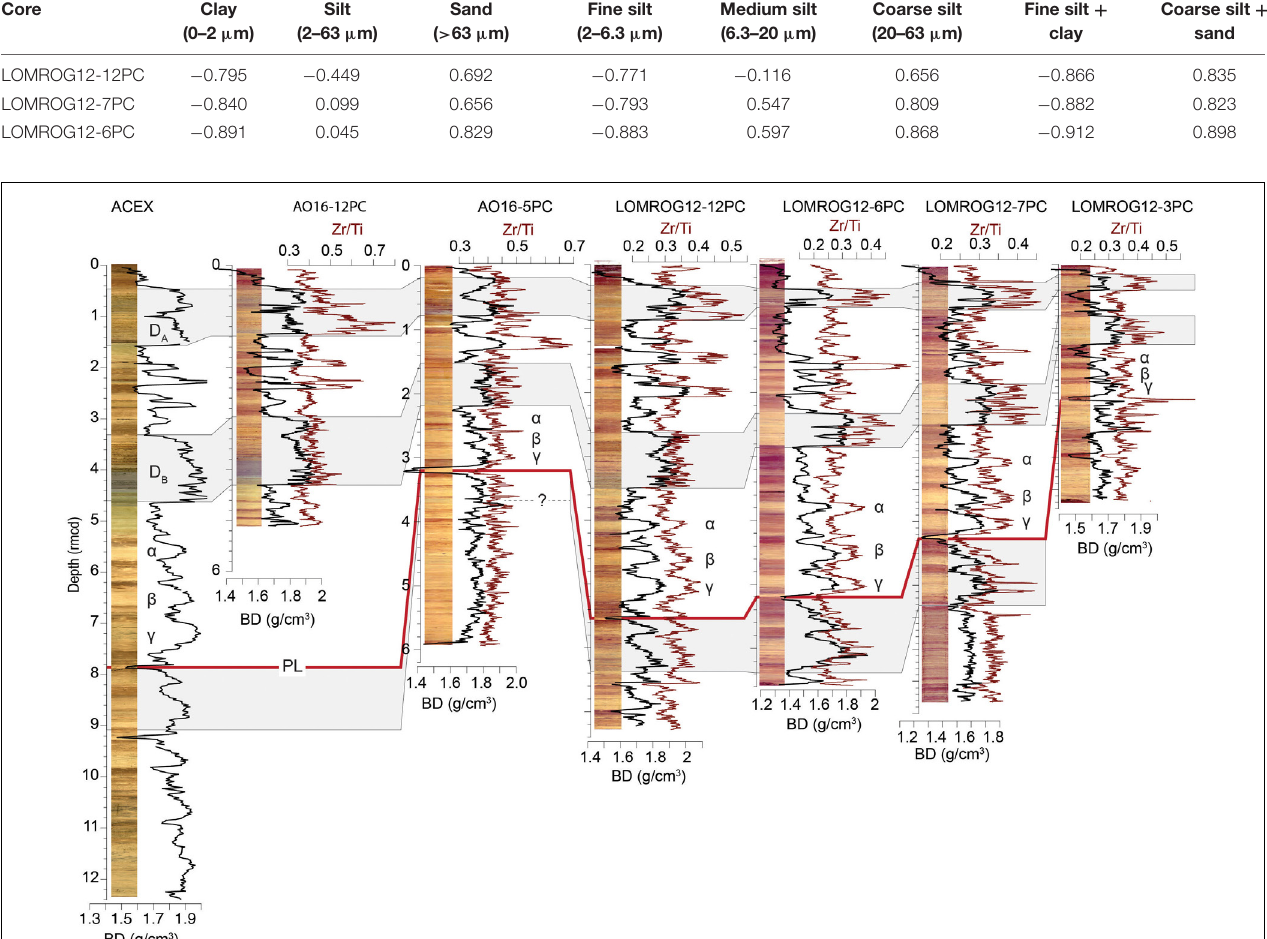
TABLE 3 | Correlation coefficients between bulk density and grain size parameters.